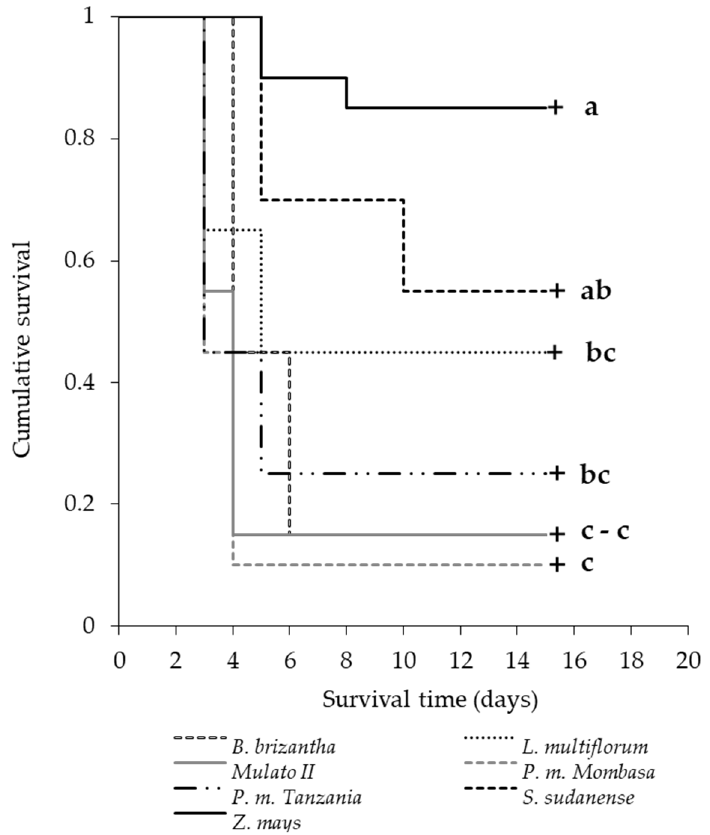
Figure 9. Survival of S. frugiperda larvae in different grasses. Lines with different letters indicate significant differences by the Holm–Sidak test ( α = 0.05). Table 6. Classification (in decreasing order of suitability) of trap plants according to the TRAPS